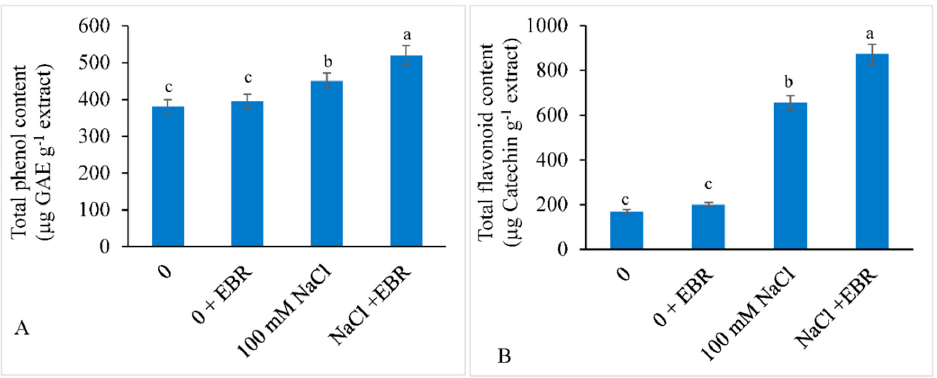
Figure 8. Effect of 24-epibrassinolide (EBR) on ( A ) total phenol content and ( B ) total flavonoid content in soybean plants under NaCl stress. Data presented are the means ± SE ( n = 5) and significant difference between the means calculated at p ≤ 0.05 using the Duncan’s multiple range test.